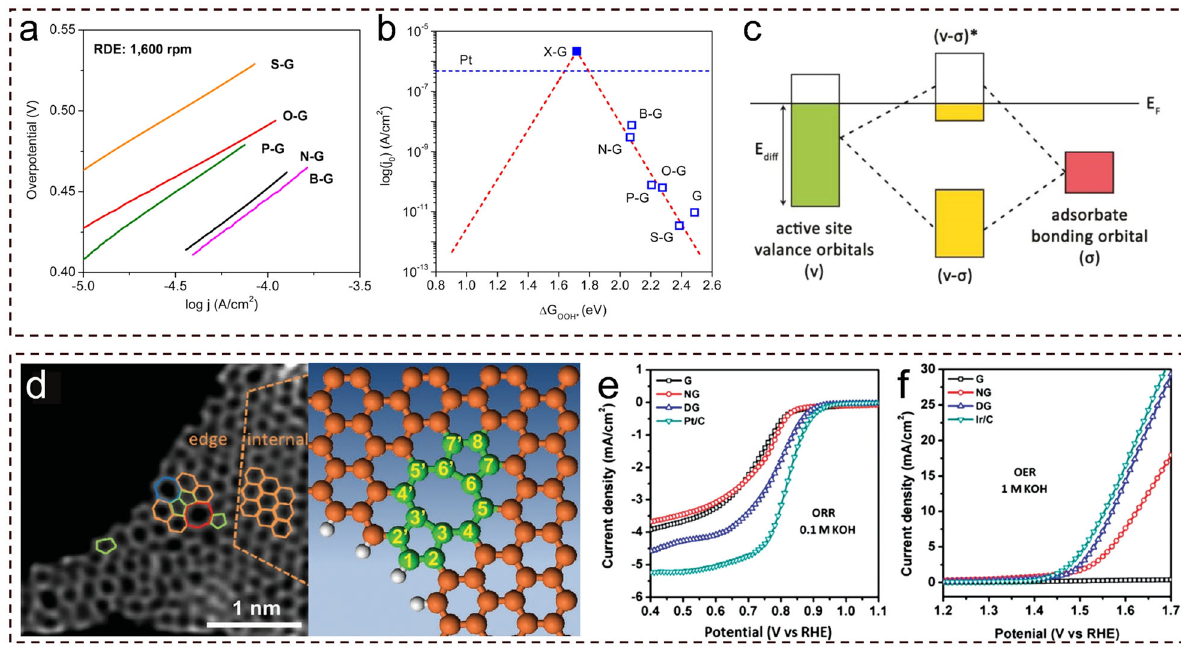
Fig. 1 HER, ORR, and OER performance of graphene-based materials. a Tafel plots and b volcano plot between j theory0 and Δ G OOH* for different heteroatom-doped graphene catalysts. c Scheme of orbital hybridization of valence band from active sites and adsorbates bonding orbital. E F refers to highest valence orbital energy of the entire graphene cluster ( a – c are reproduced with permission from ref. 61 , Copyright © American Chemical Society 2014). d HAADF image (left) and simulation model (right) of defective graphene. Linear sweeping voltammetry curves of the pristine, N-doped, and defective graphene for e ORR and f OER ( d – f are reproduced with permission from ref. 68 , Copyright © WILEY-VCH